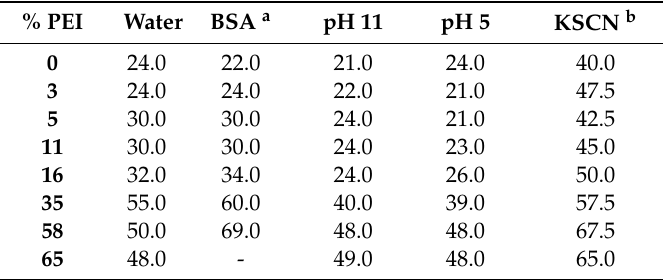
Figure 2. Aqueous solution behavior of poly(2-ethyl-2-oxazoline (PEtOx)–polyethyleneimine (PEI) comb-like copolymers and their shape transitions with temperature and composition determined by SAXS. Adapted from Halacheva et al. as published by the American Chemical Society [39]. Table 1. Phase transition temperatures (T CP , °C) of PnPOx–PEI copolymers depending on the degree of hydrolysis (DH) (PEI content) and medium. The copolymer concentration was 10 mg/mL. The T CP values were determined as the onset of aggregation from dynamic light scattering (DLS). Adapted from Mees et al. as published by the American Chemical Society [41].